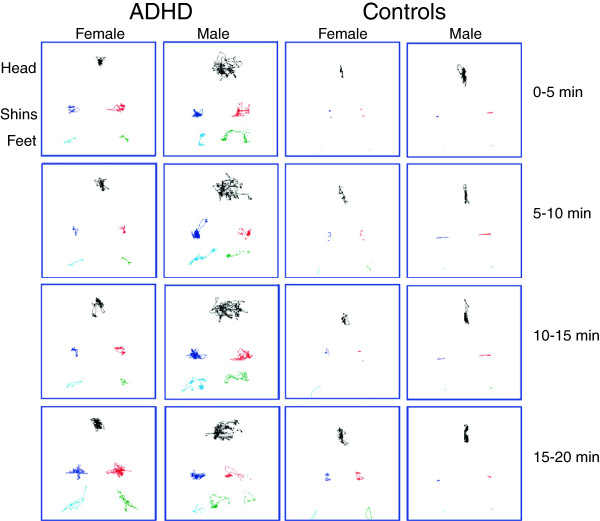
Infrared motion analysis patterns tracing the movement path of markers attached to the head, left and right shins and ankles of four representative subjects in 5-minute blocks over the course of the 20-minute cognitive control task. Subjects included in the figure were males and females from each group whose activity measures were closest to the ADHD and control group means.